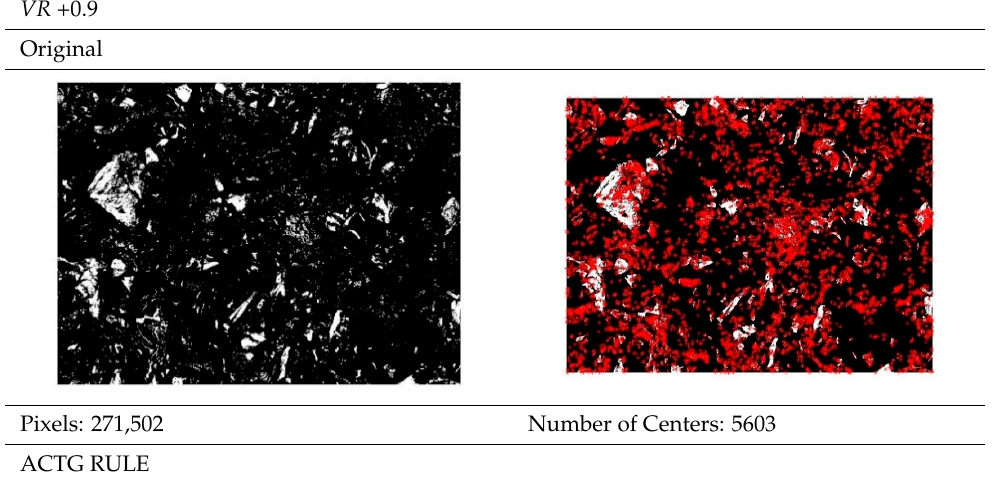
Table A3 . Images and associated pixels and number of centers corresponding to VR = +0.9.